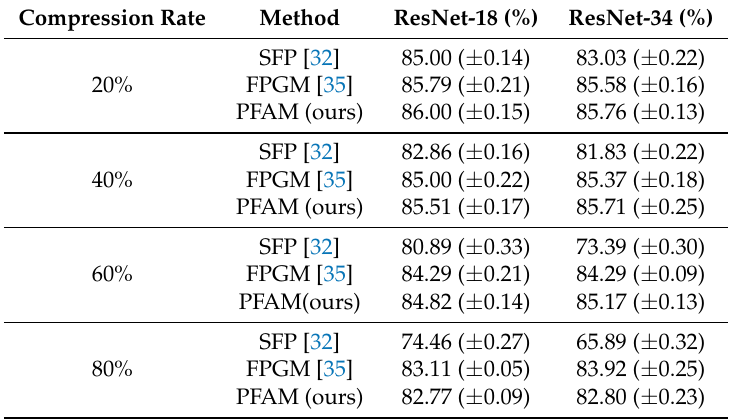
Figure 7. The comparisons among the three methods on pruning ResNet-18 ( a ) and -34 ( b ) with various pruning ratios. Table 7. The comparisons of SFP, FPGM, and PFAM for pruning ResNet on the RSSCN7 dataset with pruning ratios of 0.2, 0.4, 0.6, and